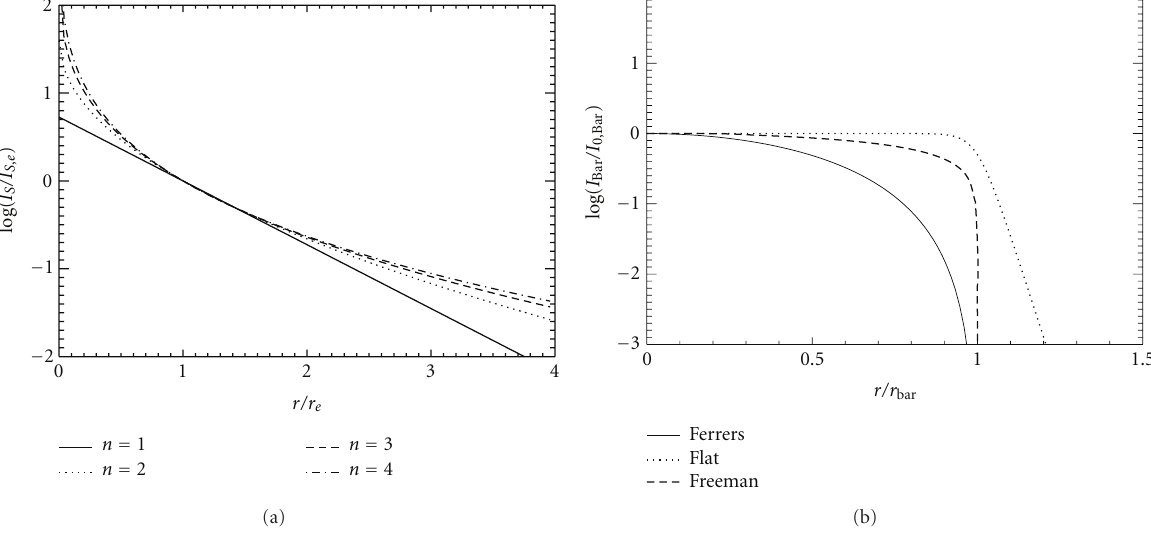
Figure 6: (a) S´ersic radial profiles with n = 1 (full line), 2 (dotted line), 3 (dashed line), and 4 (dashed-dotted line). (b) Ferrers (full line), flat (dotted line), and Freeman (dashed line) radial